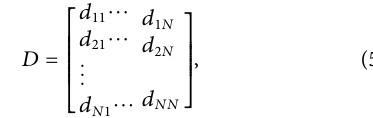
which can be represented by a network with nodes, as shown in Figure 8 below.